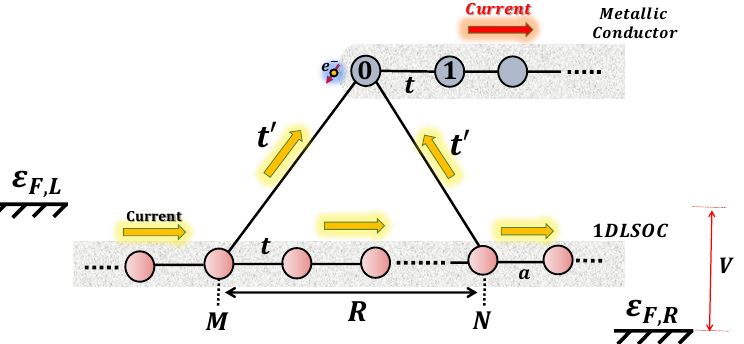
Figure 1. Diagram of the interferometer composed of a one-dimensional lead on the SOC side coupled through two contacts to a metallic